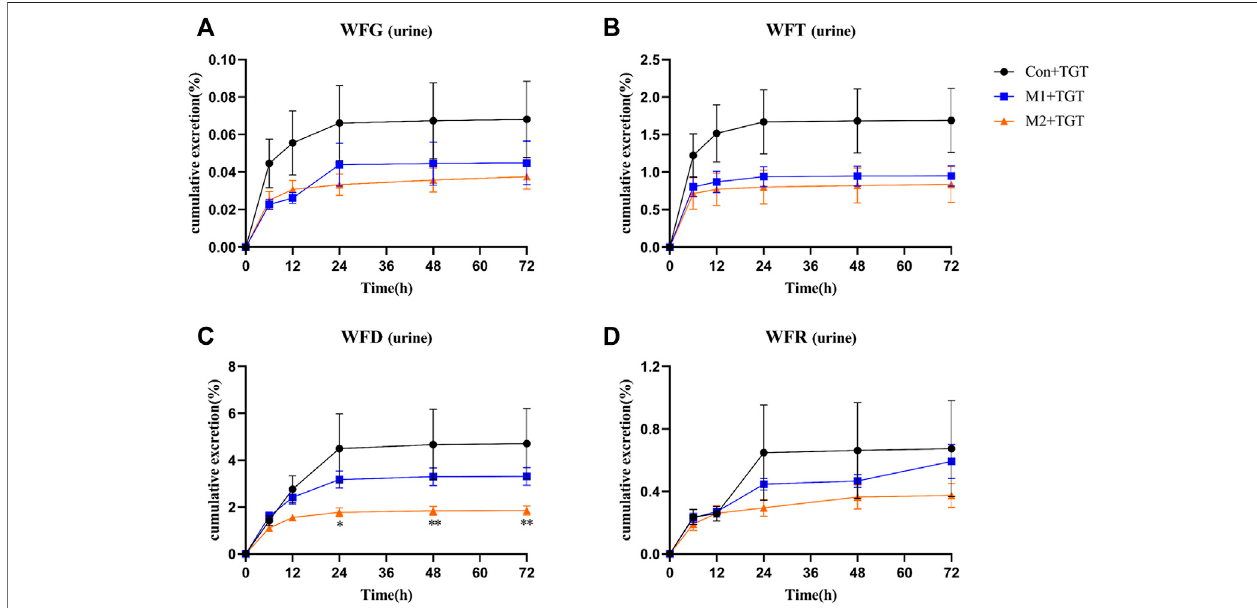
FIGURE8| ThecumulativeurineexcretionratiosofthefourkeyTGTcomponentsinthenormalandtwotypesofadriamycin-induced-NSratsafterasingleTGToral gavagedoseof10 mg/kg(mean±SD, n =7).Thenormalrats,Con+TGT,blackcircle C ;theearly-stageNSrats,M1+TGT,bluesquare ;theadvanced-stageNSrats, M2+TGT, orange triangle . WFG (A) , WFT (B) , WFD (C) , WFR (D) , p p < 0.05, pp p < 0.01 versus Con + TGT.